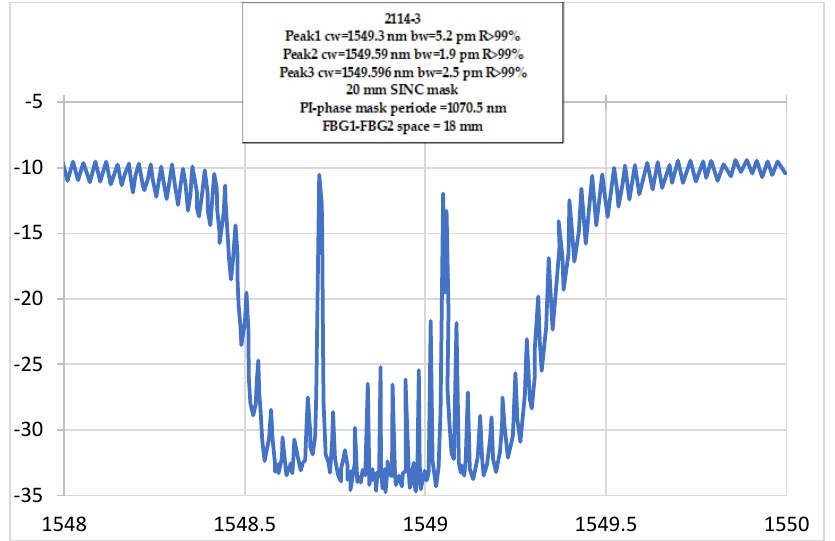
Figure 6. The smaller peak measures the ppm moisture, the larger peak measures temperature only.